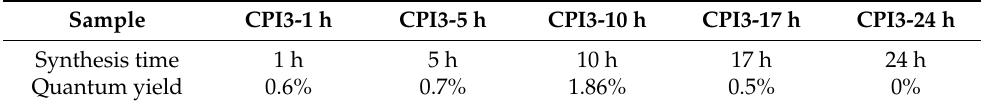
Table 2. Quantum yield vs. synthesis time.